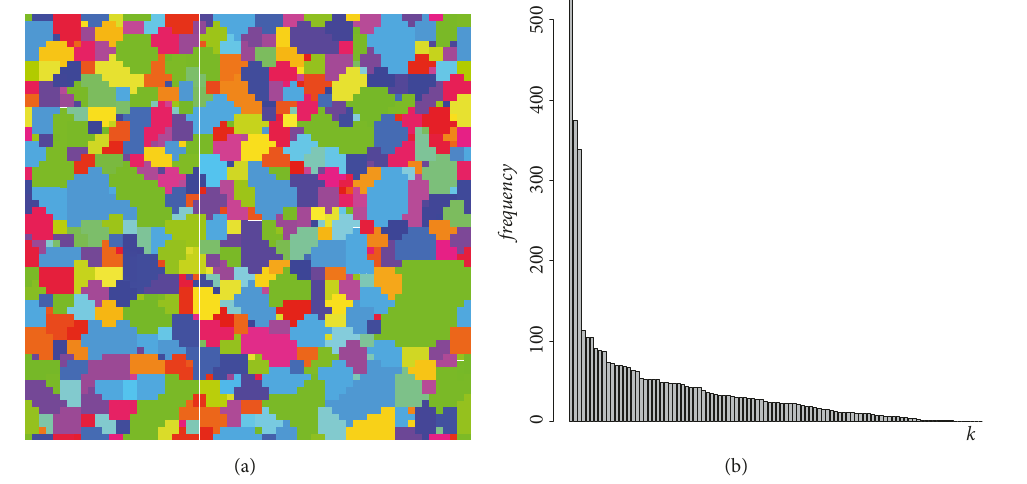
Figure 7: Example of a fixed point solution for 𝑠 = 2 , 𝑝 𝑎 = 0.25 , and 𝑝 𝑏 = 0.75 . (a) The spatial patterns of selected schools (the colormap labels the states {1,2,. .. 100} ). (b) The distribution of the number of students per school.